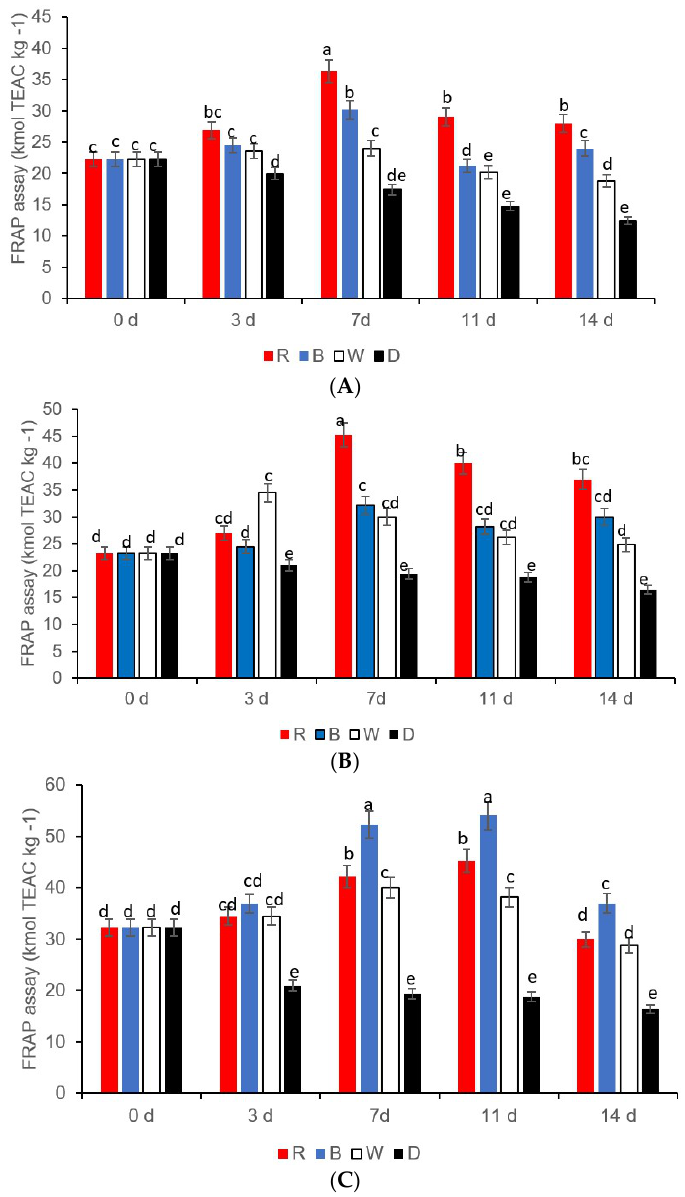
Figure 4. Antioxidant activity in ( A ) green sweet pepper, ( B ) yellow sweet pepper, and ( C ) red sweet pepper fresh-cuts exposed to different LED light treatments for 8 h at 7 °C. R—Red, B—blue, W—white light; Control—Darkness. Data include 0, 3, 7, 11, and 14 days storage time. Different letters above each bar indicate significant differences ( p < 0.05) using Fisher’s LSD test.